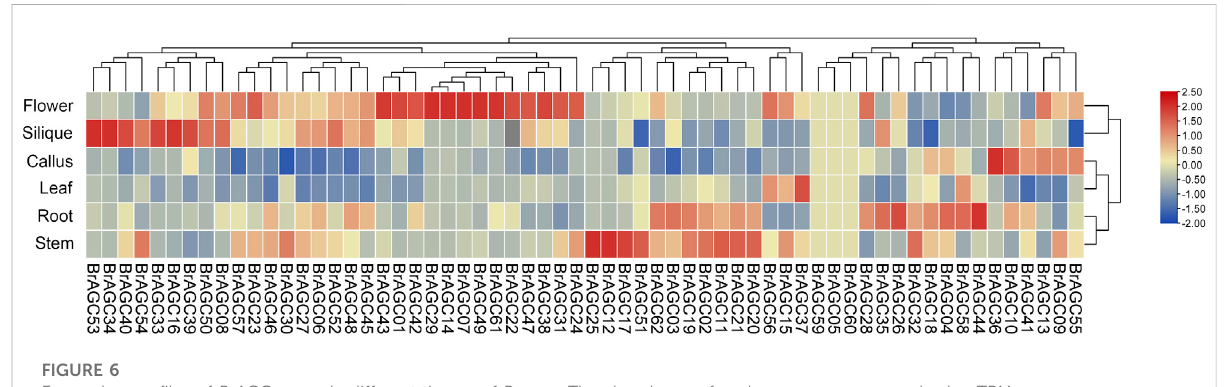
FIGURE 6 Expression pro fi les of BrAGC genes in different tissues of B. rapa . The abundance of each gene was measured using TPM.